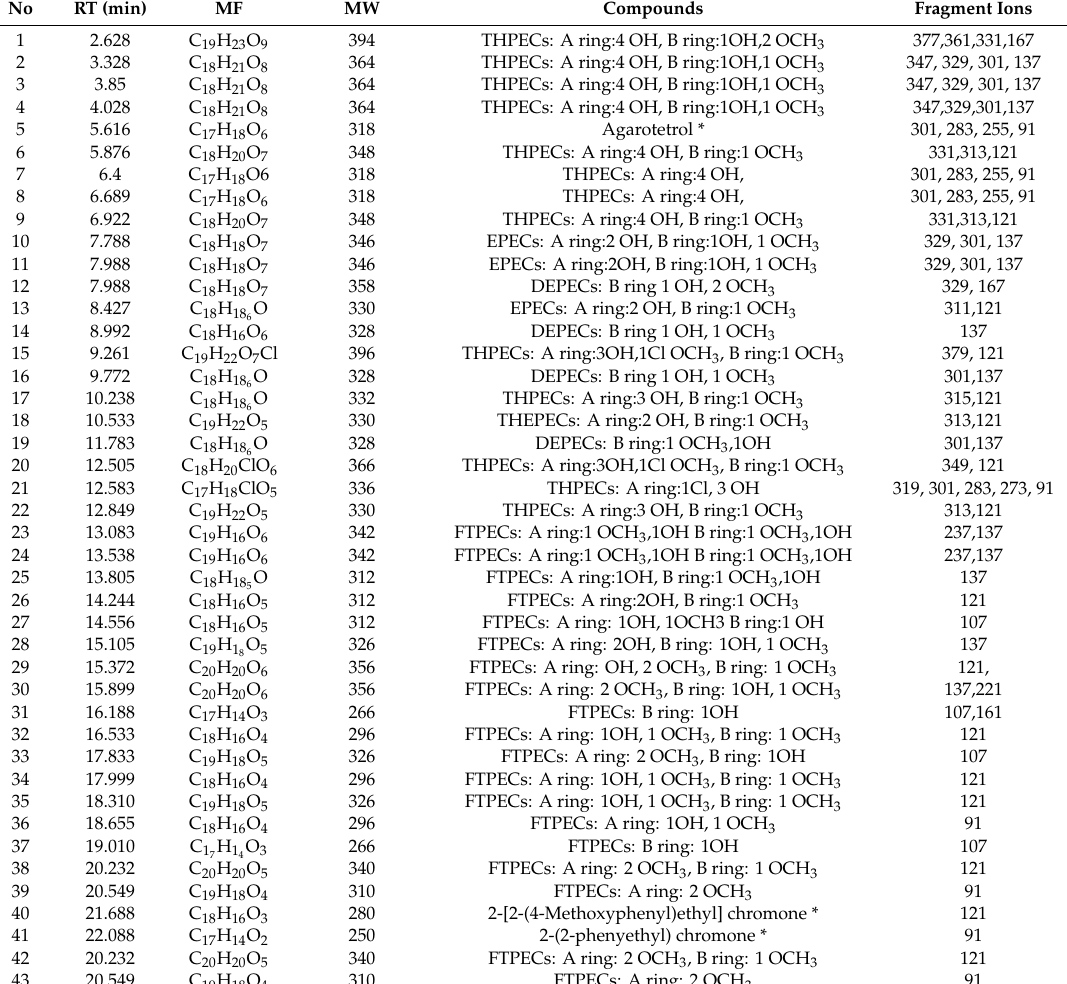
Figure 3. Total ion chromatograph (TIC) of agarwood produced by artificial induction methods ( A ) and the characteristic structures of four types of 2-(2-phenylethyl)chromones, ( B ) detected by LC-MS. group A, wounding by axe; group B, burning-chisel-drilling; group C, chemical inducers; group D, biological inocula. Table 2. Tentative identification of 2-(2-phenylethyl) chromones (PECs) in artificial agarwood. No RT (min) MF MW Compounds Fragment